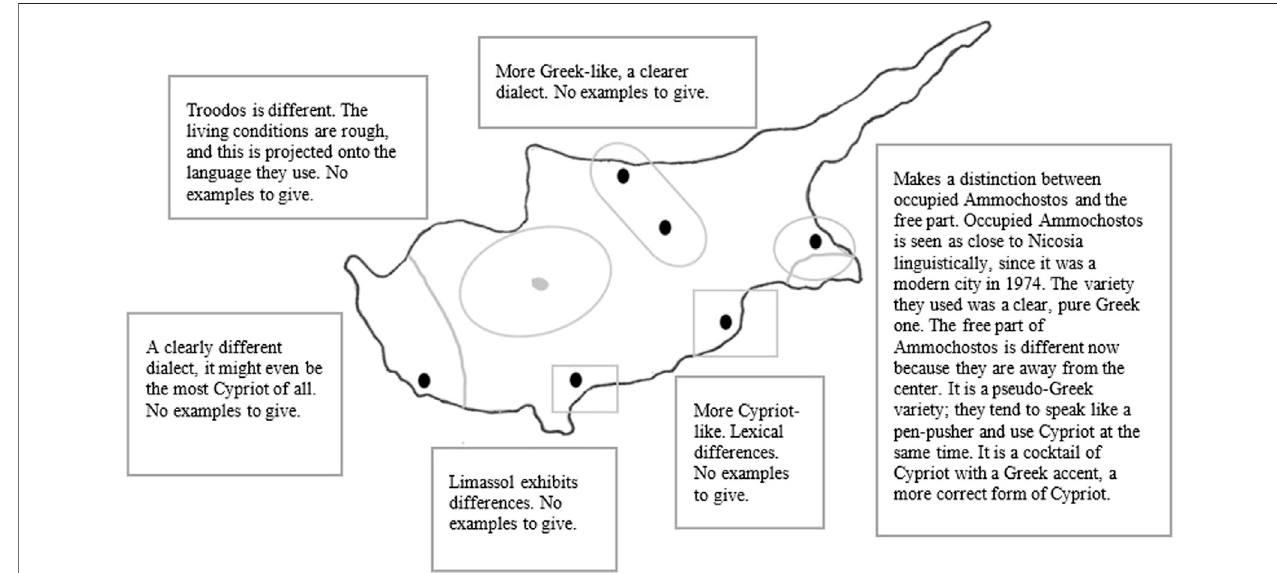
FIGURE 10 | Map drawn by participant